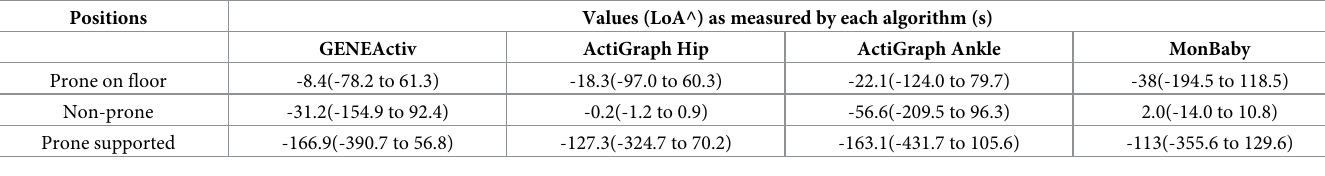
Table 4. Values (LoA^) when compared to direct observation from Bland-Altman